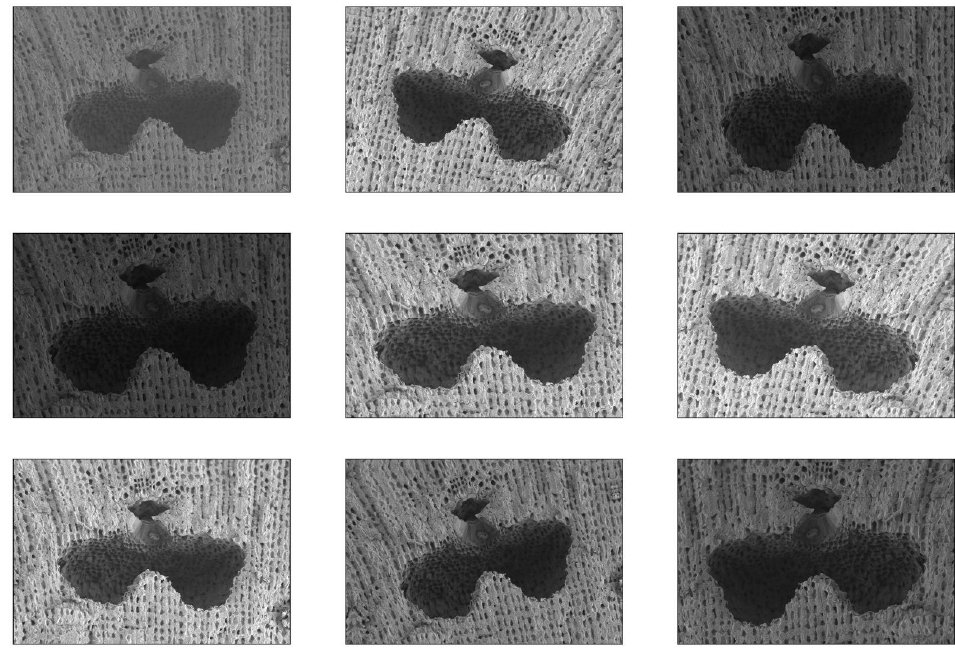
Figure 2. Examples of augmented images of a Lithophyllum racemus conceptacle given the original image in the first position (upper left).